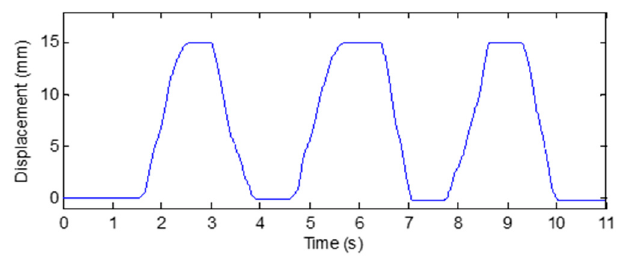
Figure 10. Response testing device. ( a ) Wooden finger; ( b ) Wooden finger with a sensing unit.